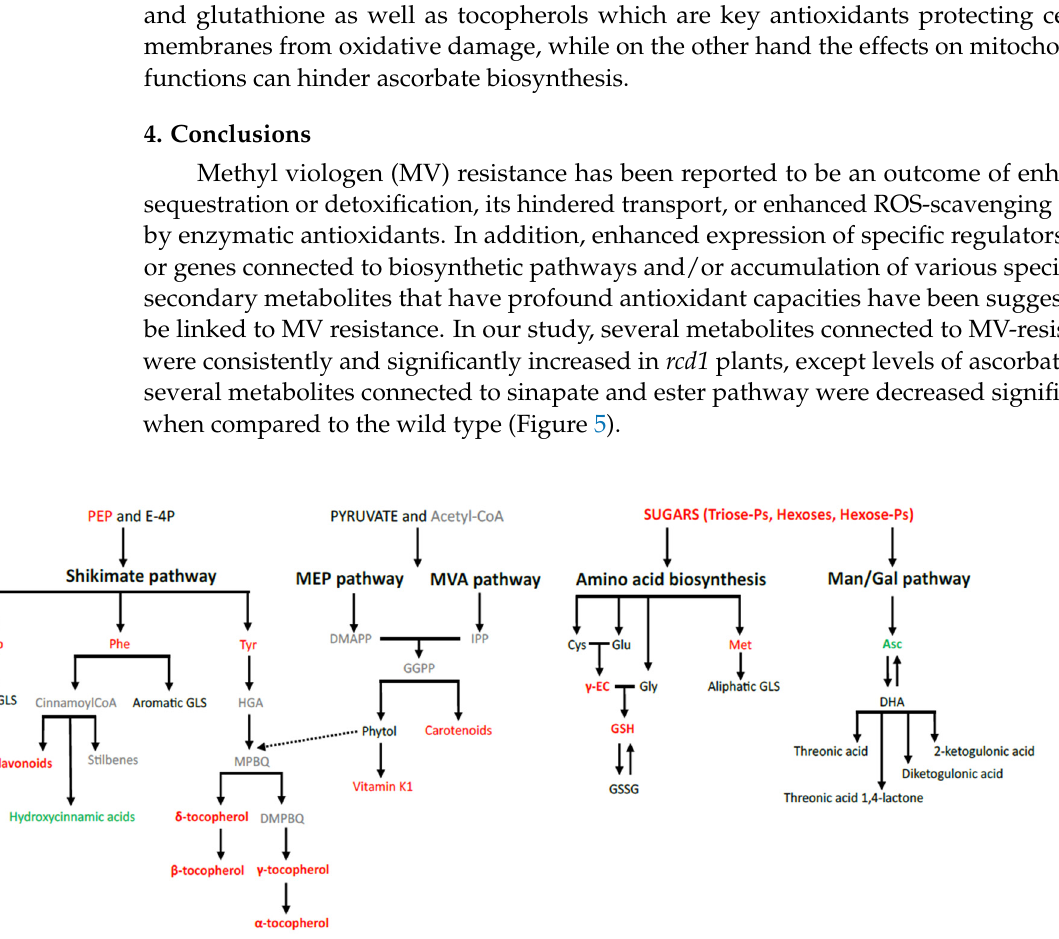
Figure 5. Simplified illustration of altered, specialized metabolic pathways by RCD1: carotenoid biosynthesis via MEP (methyl erythritol phosphate), MVA (mevalonate) pathways, shikimate path- way connected to aromatic amino acids, tocopherol and phylloquinone pathway, and aromatic and indole glucosinolates (GLS), as well as flavonoid, stilbene, and hydroxycinnamic acid (HCA) path- ways. Black, red, and green colors indicate similar, increased, or decreased metabolite levels in rcd1, respectively. Grey metabolites were not detected. Amino acids (Phe, Tyr, Trp, and Met), phytol, ascorbate (Asc and DHA), and tocopherol levels measured previously with GCMS in Sipari et al. [13].